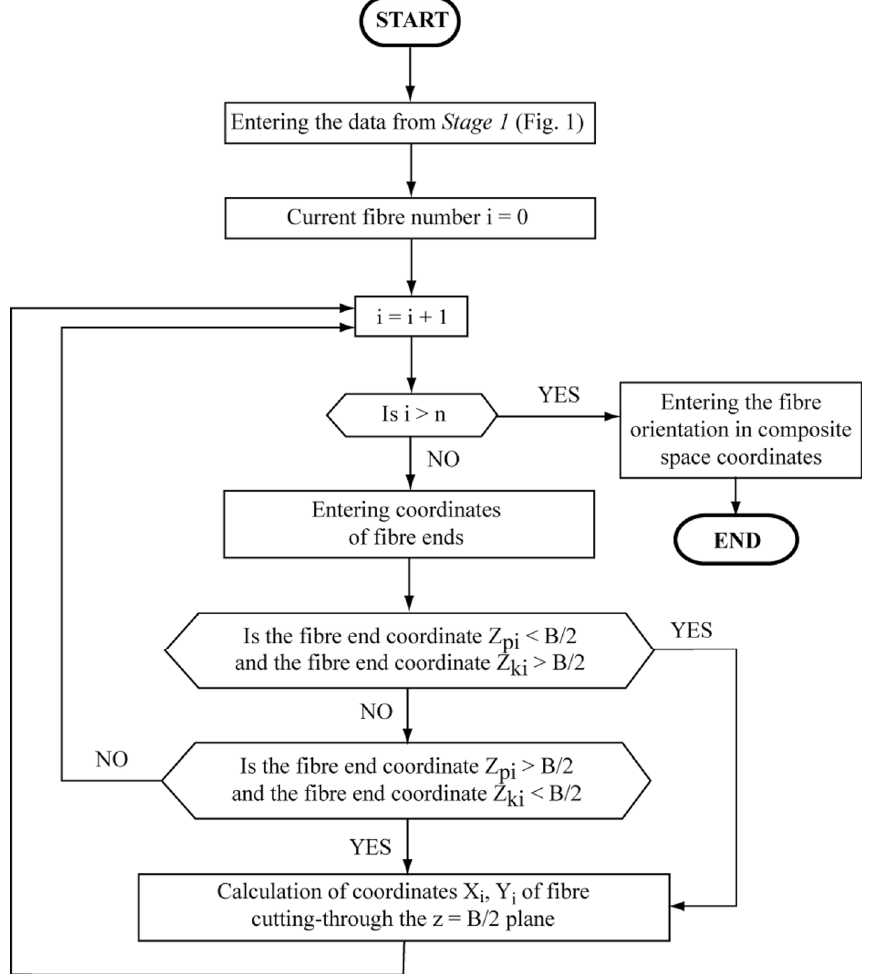
Fig. 4. Calculation algorithm for the coordinates of fibre cut-through points on the cross-section surface of composite space – the second stage of